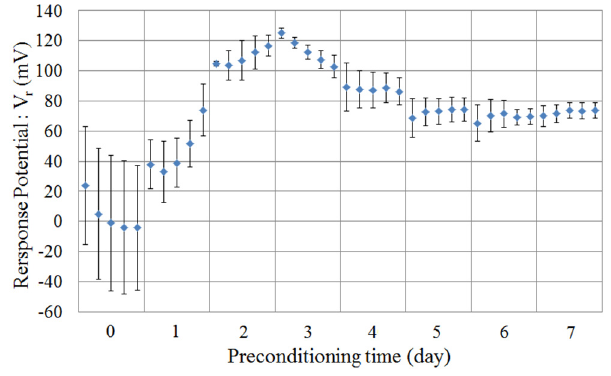
Figure 4. Relationship between the response potential to the reference solution (30 mmol/L KCl + 0.3 mmol/L tartaric acid) and the preconditioning time. Data are expressed as mean ± SD (n = 4).